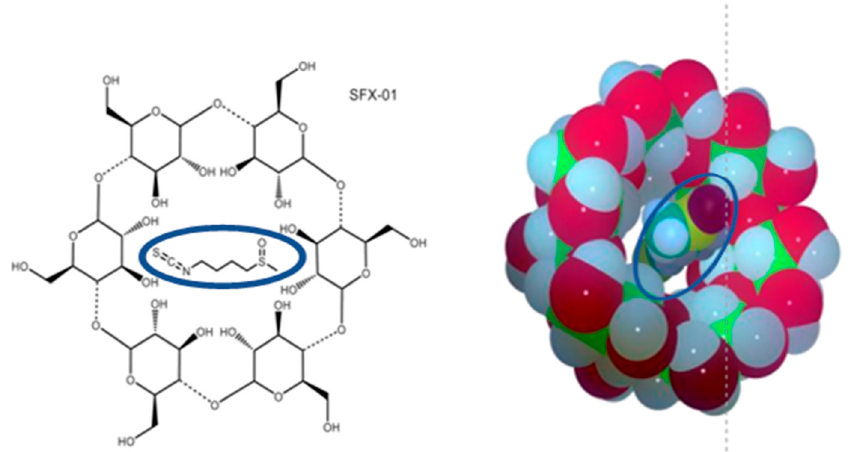
Figure 1. Chemical structure and three-dimensional representation of SFX-01. The cyclodextrin alpha (Cavamax-W6 ® (Wacher Chemie AG, Adrian, MI, USA) shows 6 glucose units has the smallest cavity of the parent cyclodextrins. It is useful for solubilizing, stabilizing, or delivering small molecules. SFN structure is present in the core of molecule (outlined with a blue line).